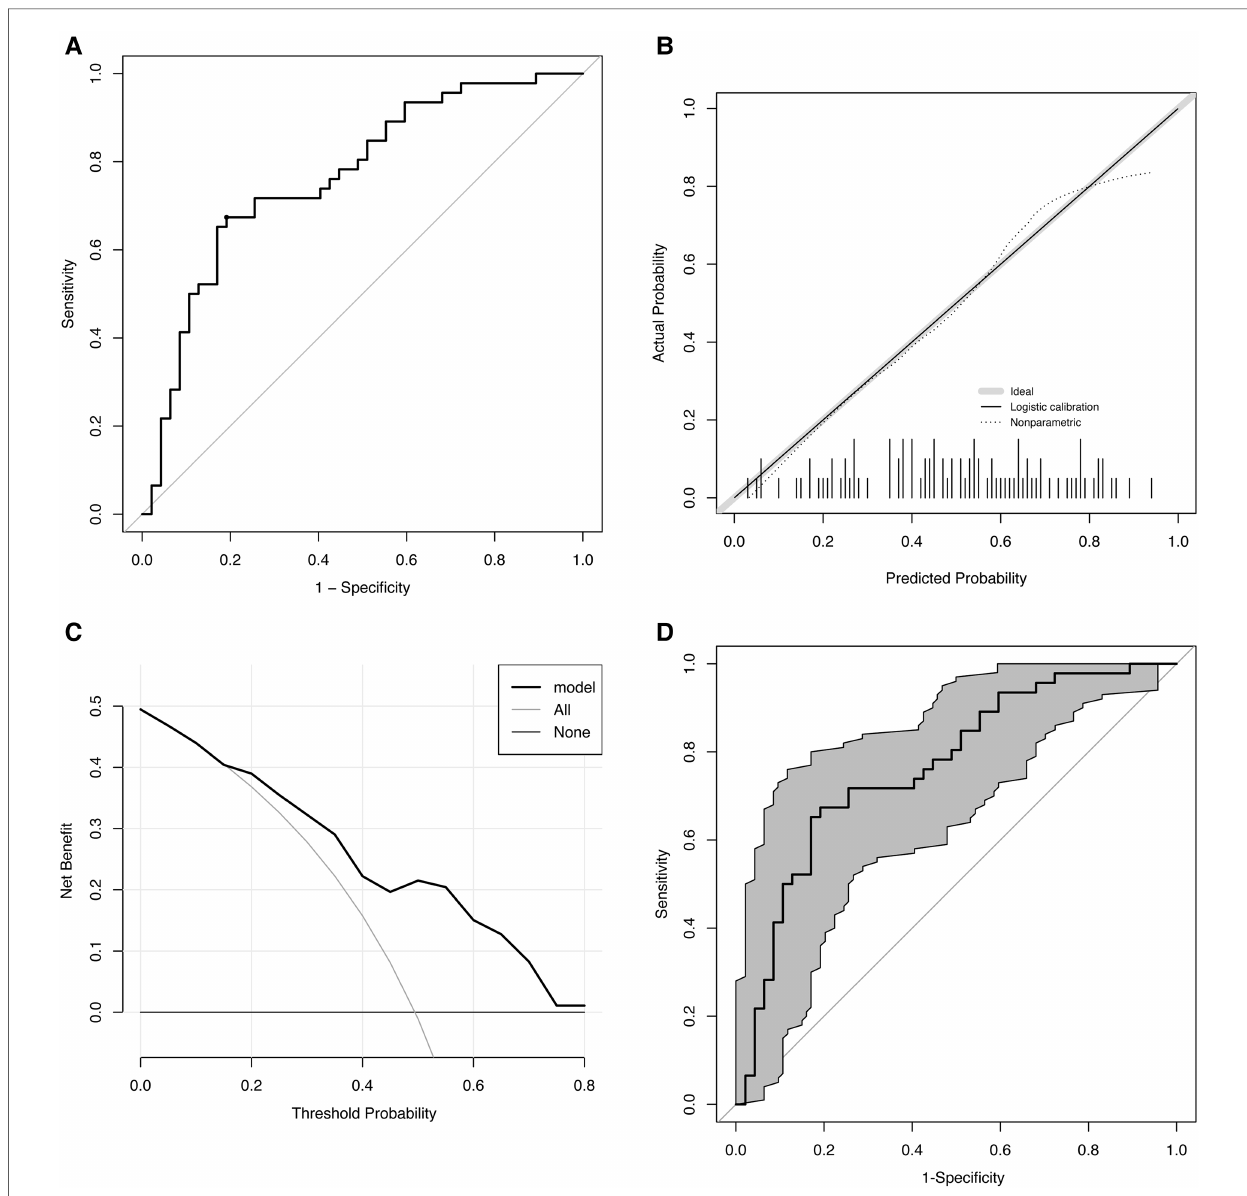
FIGURE 2 Evaluation of the predictive model. ( A ) ROC. AUC: 0.77 ( p <0.01), cut-off value: 0.5, sensitivity: 67.4%, and speci fi city: 80.9%. ( B ) Calibration curve. The gray line indicates the ideal reference line where predicted (x-axis) and observed probability (y-axis) coincide. The black line represents the performance of the model. The closer the black line is to the gray line, the more accurately the model predicts. ( C ) DCA. ORS treatment is regarded as an intervention, and the purpose of the ORS is naturally to obtain a “ good result ” (positive outcome). DCA includes results for “ ORS for all, ” “ ORS for none, ” and “ ORS for model. ” The x-axis displays the probability threshold. The y-axis indicates the degree of bene fi t to which the patient bene fi ted from the intervention (ORS). ( D ) Bootstrap-corrected receiver operating characteristic curve ( n =1,000). The gray part is the 95% con fi dence interval (0.67 – 0.86). ROC, receiver operating characteristic curve; AUC, area under receiver operating characteristic curve; DCA, decision curve analysis; ORS, oral rehydration